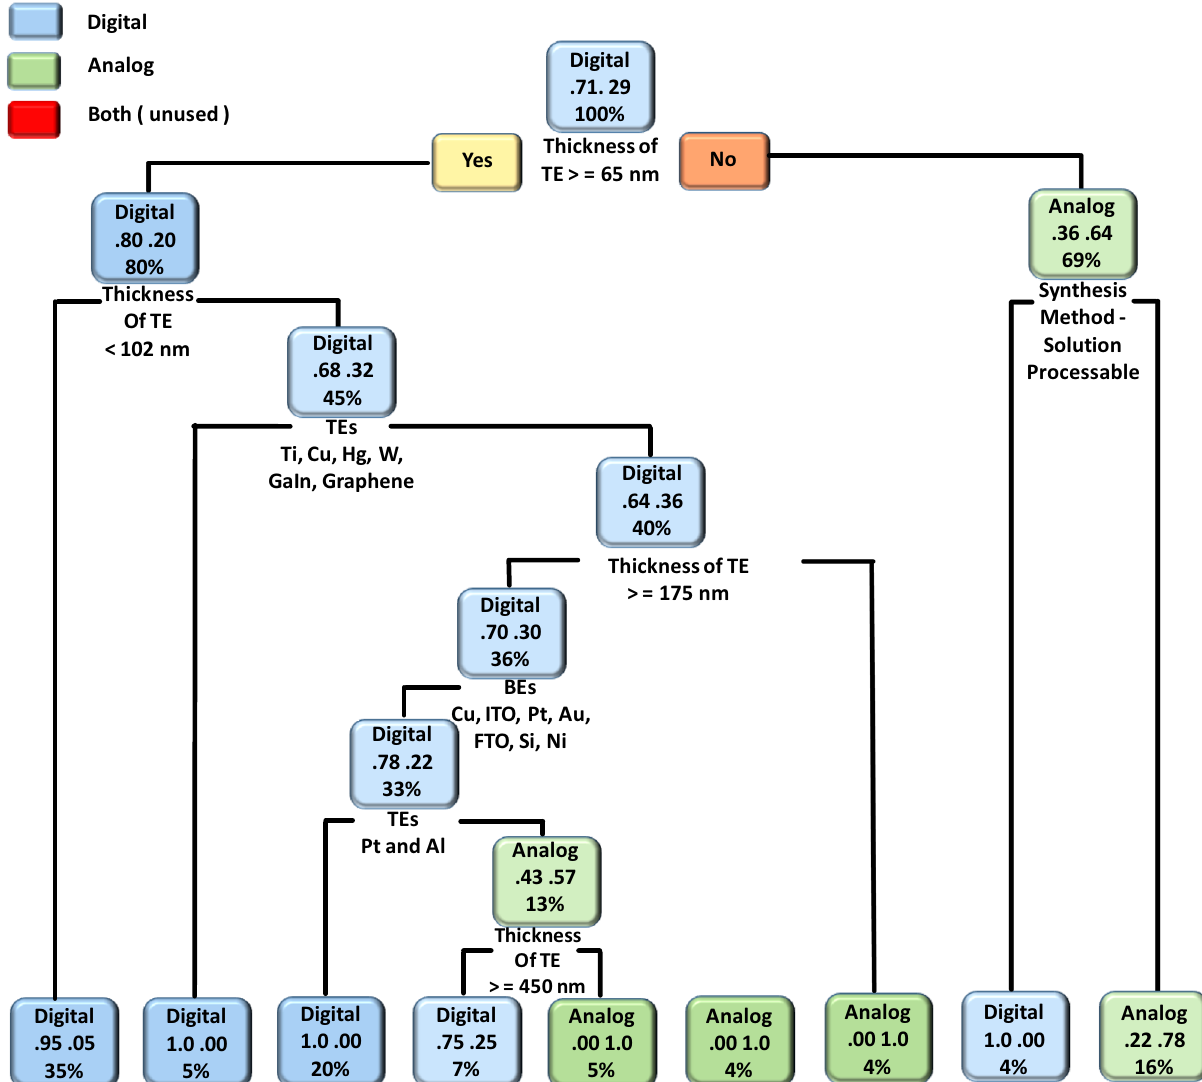
Figure 3. The DT model of the type of switching (analog, digital, or both). The present model suggests an impact of device fabrication parameters on the type of switching (analog, digital, or both) of copper oxide-based RS